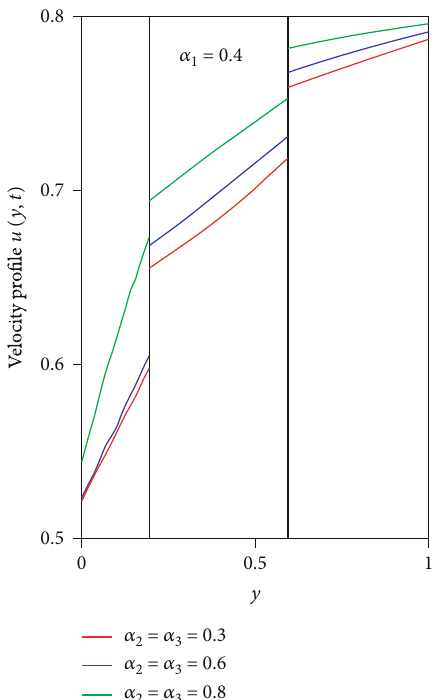
Figure 11: Velocity pro fi les u multilayer Maxwell fl uid at t = 0 : 19, λ and di ff erent values of fractional parameters α